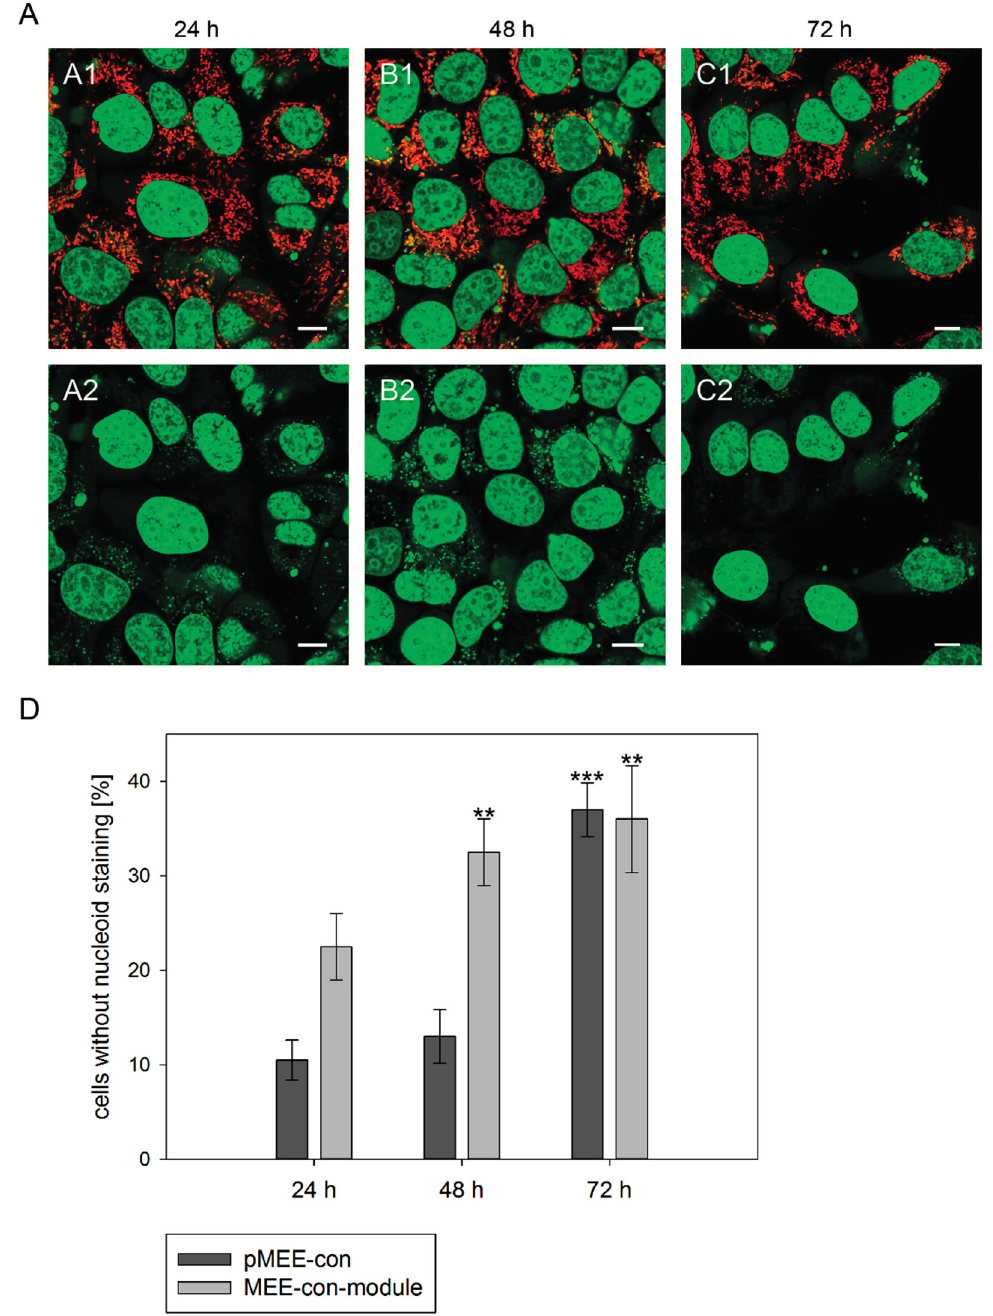
Figure 3. Analysis of nucleoid staining in 143B.TK − cells. ( A ) Confocal images. 143B.TK − cells transfected with pMEE-con were analyzed by microscopy. The nucleus and nucleoids are stained green (PicoGreen ® ; panels A2 – C2 ). The mitochondrial network was stained with MitoTracker ® Red CMXRos and co-localizes with green-stained nucleoids (panels A1 – C1 , overlay). A few cells do not show nucleoid staining (indicating ρ 0 status). Calibration marks correspond to 10 µm; ( D ) Quantification of images. More than one hundred 143B.TK − cells were counted and analyzed. The diagram shows the percentage of cells without nucleoid staining after transfection with various depletion systems. Bars describe the arithmetic mean ± SD. ** p < 0.01, *** p <